Question: Express in one sentence what the figure is showing.
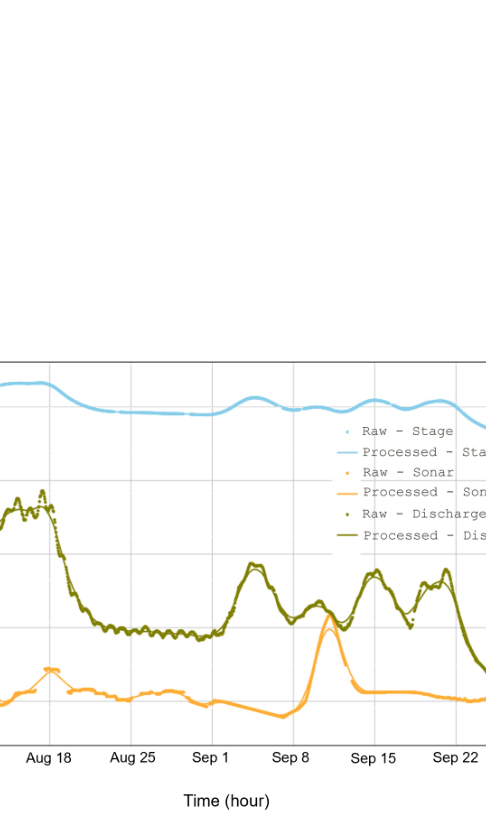
Answer: Raw vs. Processed data - Alaska 539 bridge.